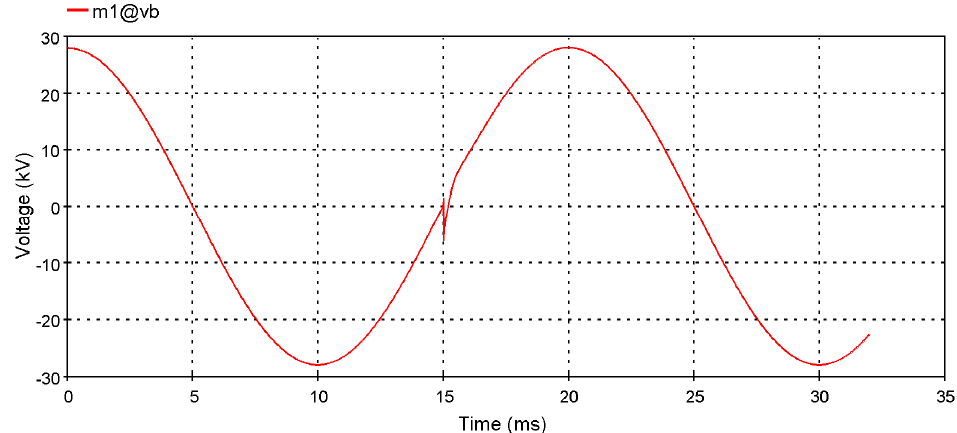
Figure 10. Limited overvoltage at the secondary side of the main power transformer with